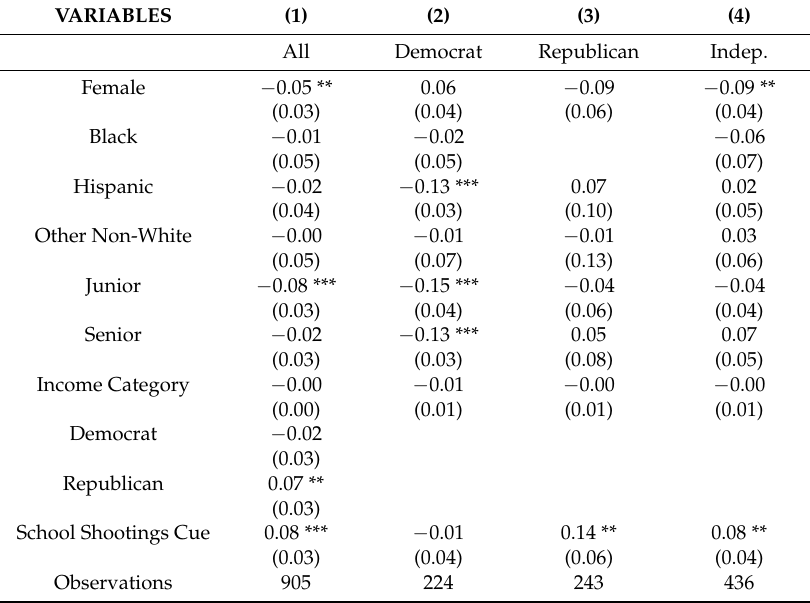
Table 3. Emotional cues and attitudes towards arming school employees. Probits: Dependent variable equals one if strongly agree with the statement that “schools that have properly trained and armed nonteaching staff would become safer